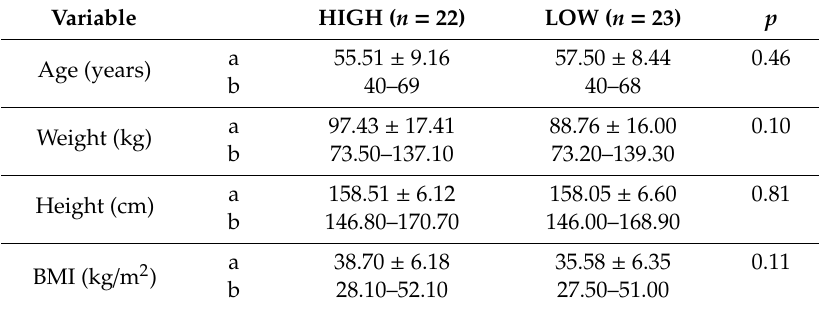
Table 1. General characteristics of the participants before the intervention